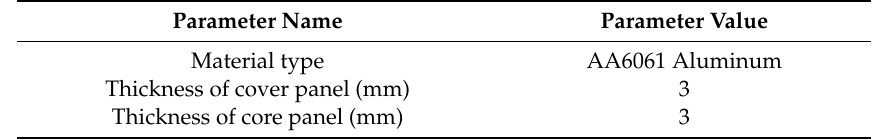
Table 2. The primary specimen parameters.